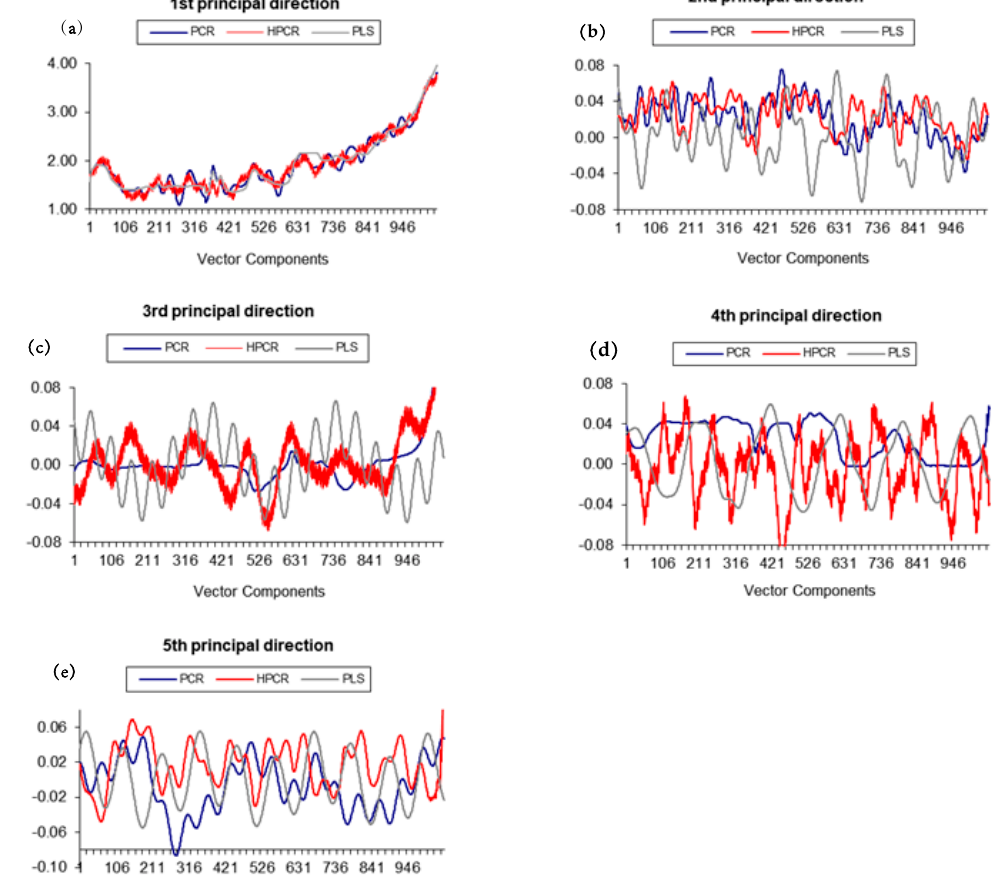
Figure 6. Principal directions of model calibrations using PLS, PCR and H-PCR at 90 °C and 450 rpm ( a ) first principal direction; ( b ) second principal direction; ( c ) third principal direction; ( d ) fourth principal direction; ( e ) fifth principal direction.